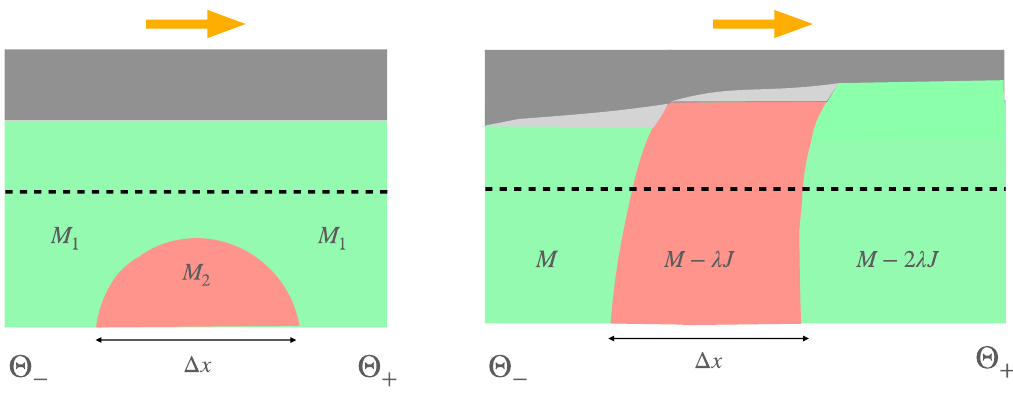
Figure 8 . The two types of NESS for an interface pair. In the ‘quantum phase’ (left) heat conducts as if there was no scatterer, while in the ‘classical phase’ (right) the conductance is the same as for an isolated CFT defect dual to a brane of tension 2 λ . Also given in the figure is the BTZ mass 1 parameter in different regions of the geometry. The yellow arrows show the direction of heat